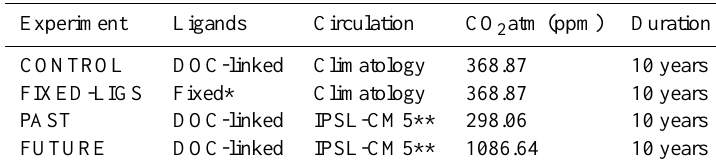
Table 1. A summary of the different Fe speciation simulations conducted. Note that for all simulations, the biogeochemical component of the ocean model has been run from the pre-industrial period prior to our Fe speciation tests in order to have an accurate three-dimensional distribution of anthropogenic carbon and thus ocean pH, as well as all other biogeochemical tracers such as the three dimensional distribution of dFe. For CONTROL and FIXED-LIGS, this involved a simulation from 1860 to 2000.